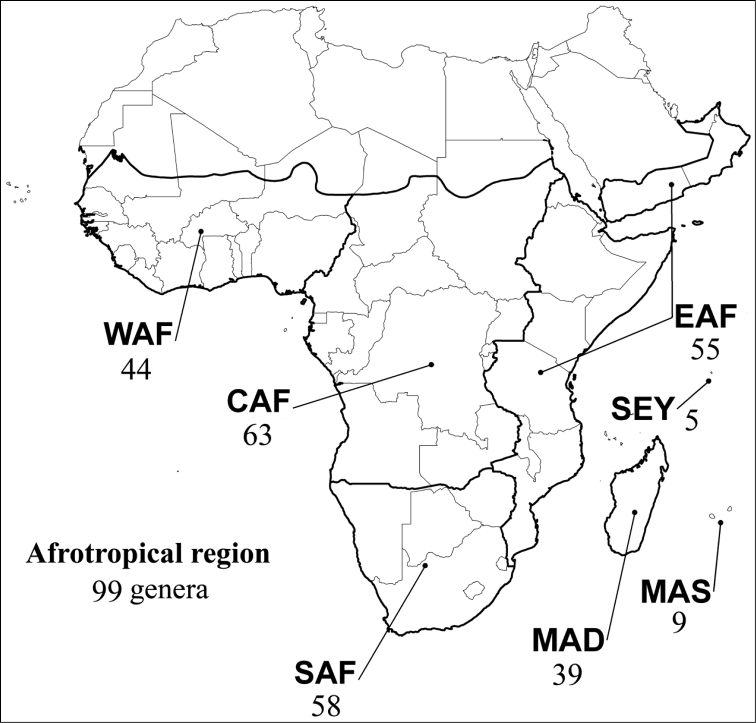
Number of flea beetle genera occuring in the various areas of the Afrotropical region (CAF: Central Afrotropical; EAF: Eastern Afrotropical; MAD: Madagascar; MAS: Mascarene Islands; SAF: Southern Afrotropical; SEY: Seychelles Islands; WAF: Western Afrotropical.) (updated from Biondi and D’Alessandro 2010a).